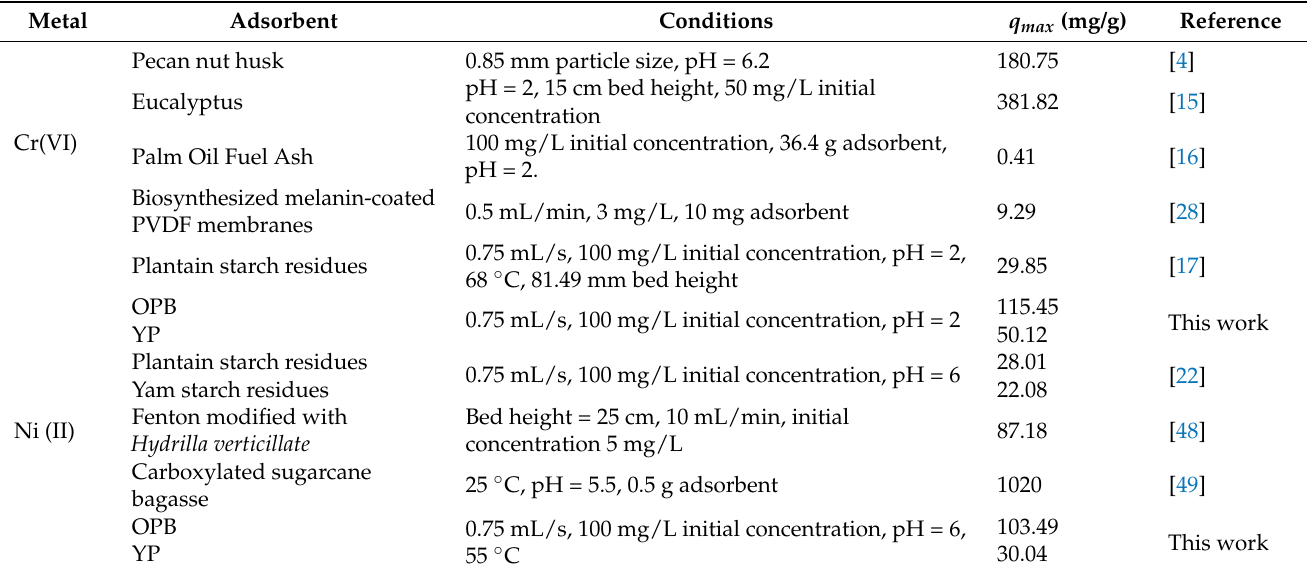
Table 4. q max of Cr(VI) and Ni(II) in a fixed bed using various